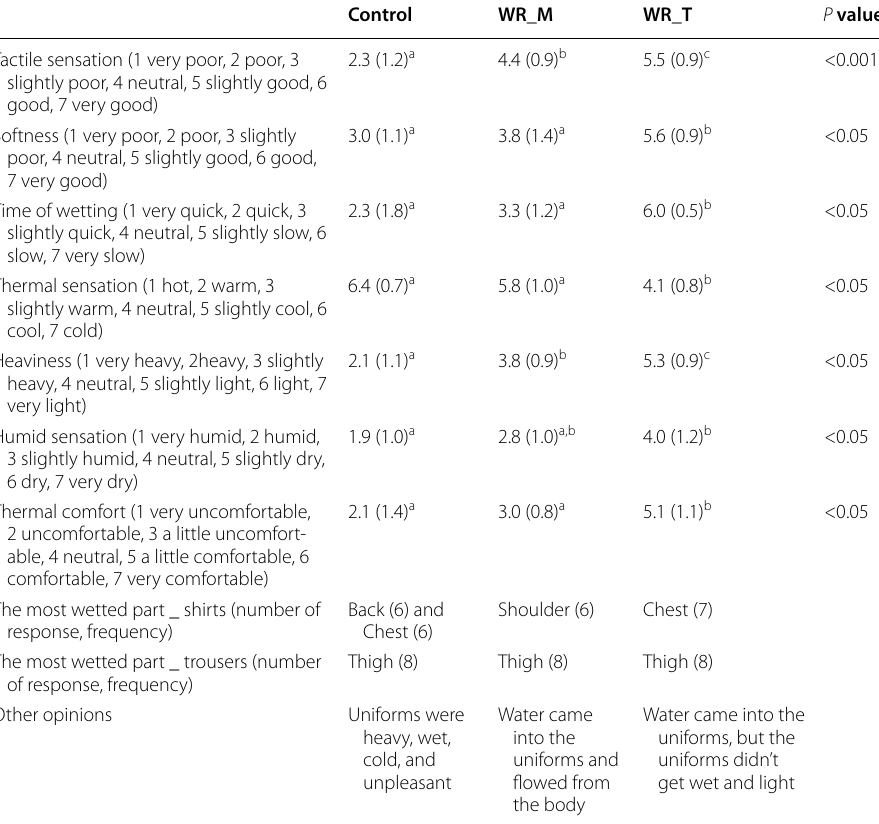
a, b and c mean significant differences among the three groups by Tukey’s post hoc